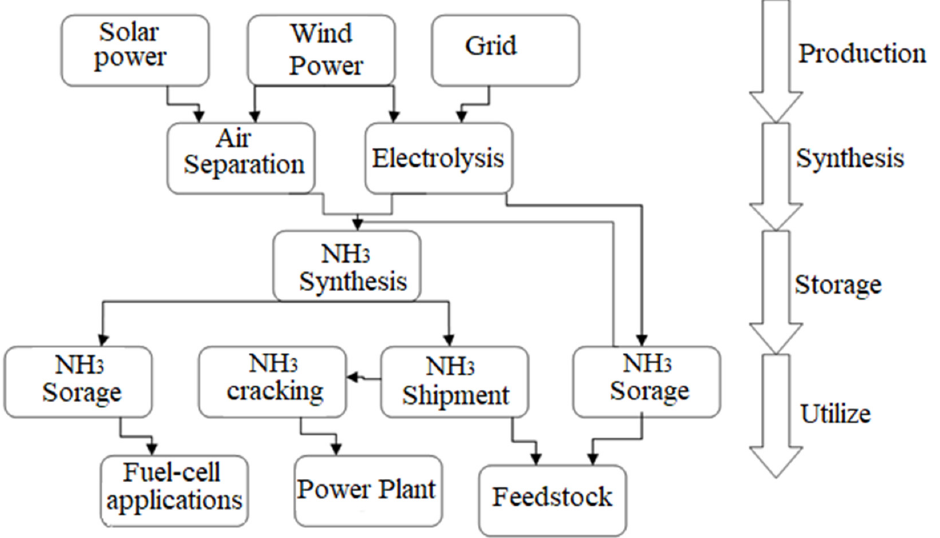
Figure 6. Schematics of the green ammonia process from production to utilization, reproduced from Reference [33].